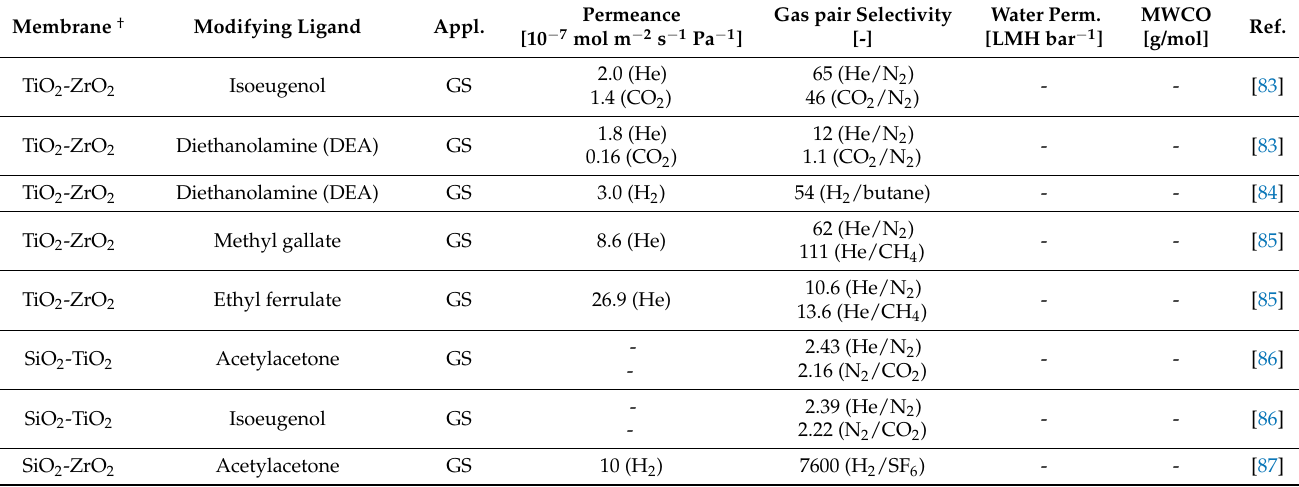
Figure 11. The preparation flow of ligand-modified composite ceramic networks involving a chelation step, followed by the co-hydrolysis and polycondensation step. Table 1. Different ligand-modified composite ceramic membranes and their applications.